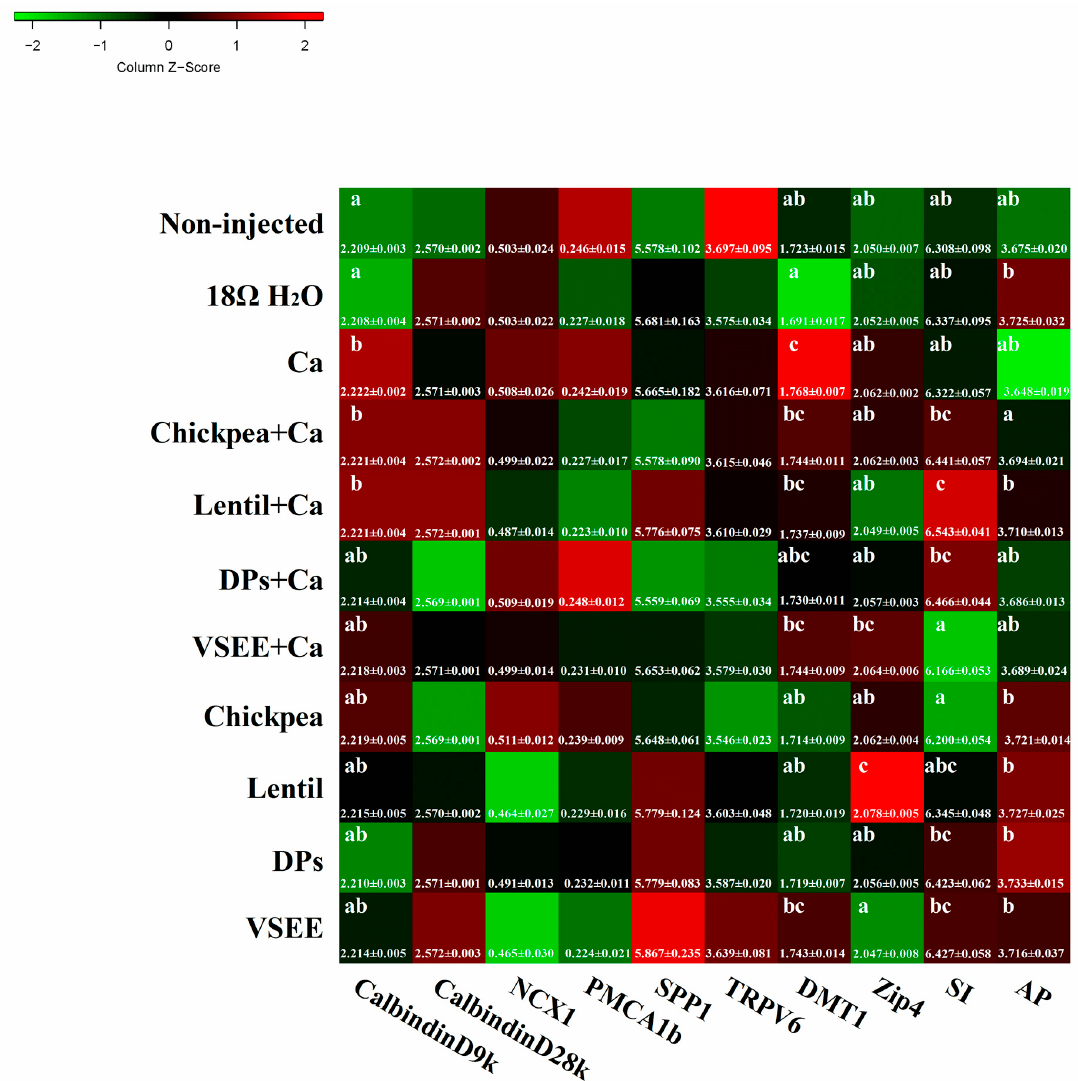
Figure 5. Effect of intra-amniotic administration of experimental solutions on the intestinal gene expression. Values are means ± SEM, n = 5. a–c Per gene, treatments groups not indicated by the same letter are significantly different ( p < 0.05). AP, Amino peptidase; SI, Sucrose isomaltase; Zip4,